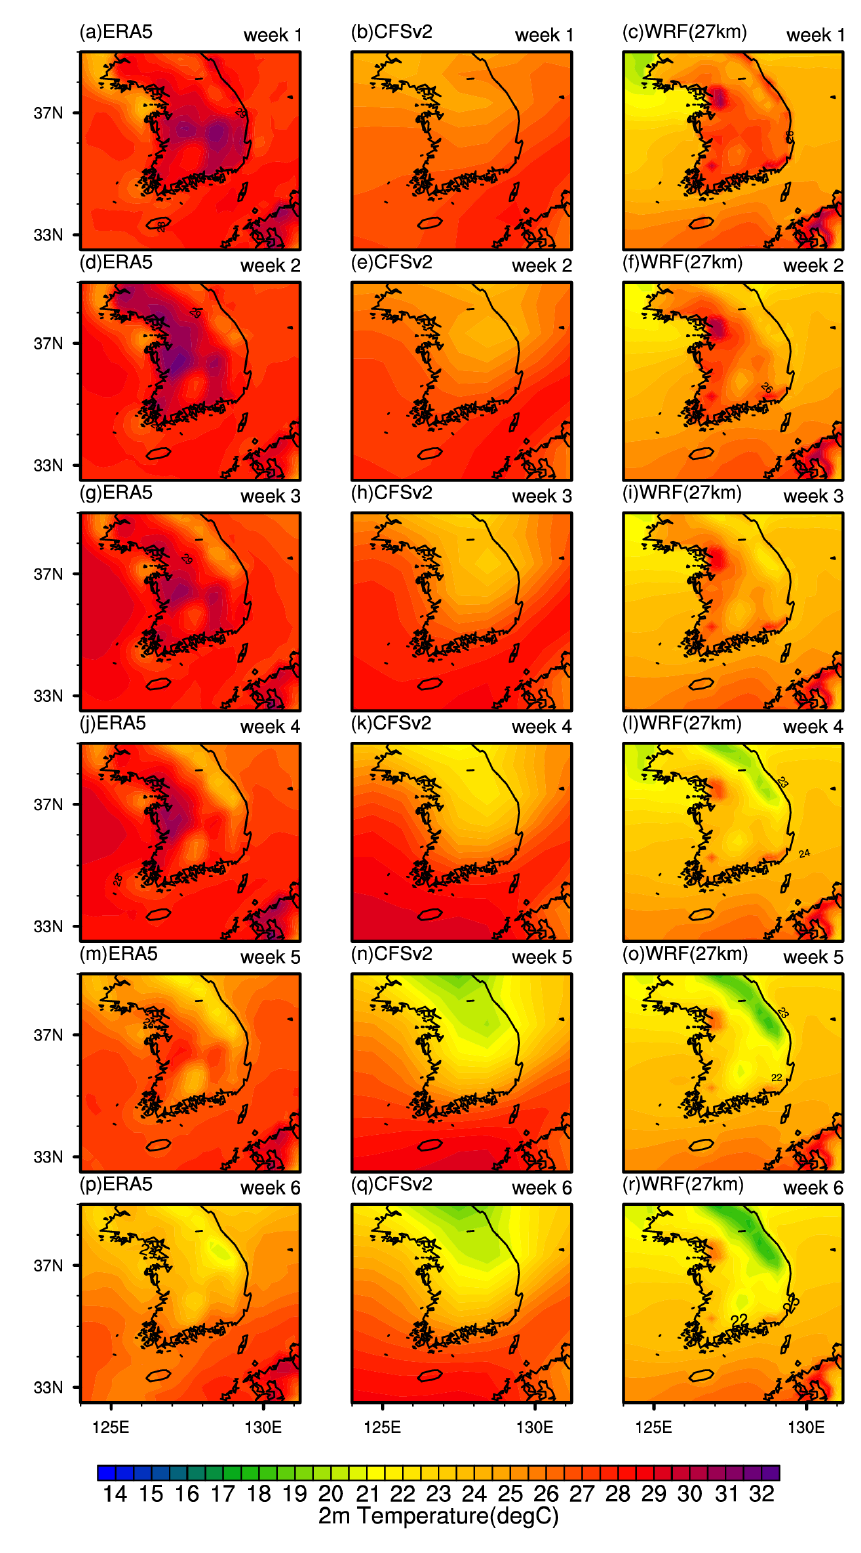
Figure 6. Same as Figure 5, except that CFSv2 and WRF were initialized at 1800 UTC on 17